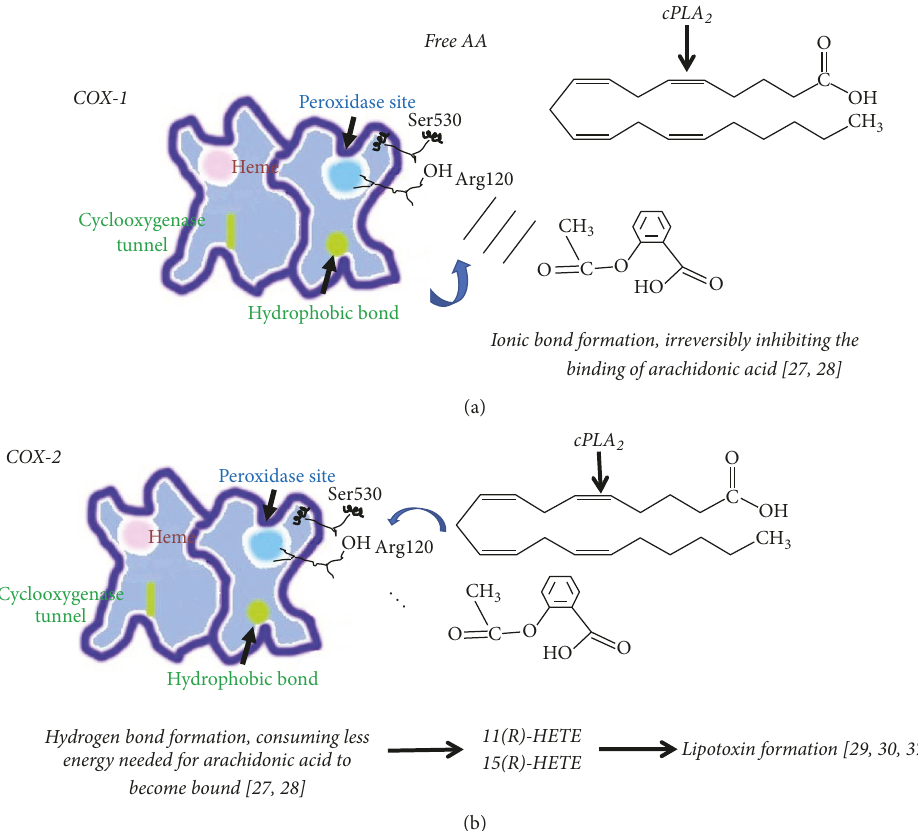
Figure 2: (a) Aspirin acetylation of COX-1 irreversibly inhibits arachidonic acid to become bound, whereas (b) acetylation of COX-2 leads to the formation of lipoxins [27–30,